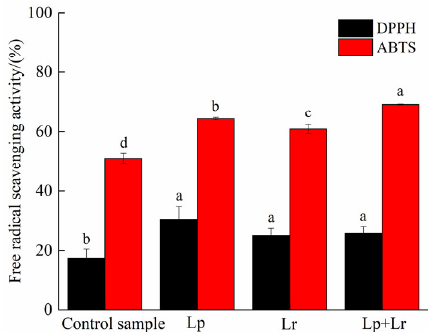
Figure 7. DPPH radical scavenging activity and ABTS radical scavenging activity of edible grass during fermentation. Different superscript letters in the columns indicate significant difference ( p < 0.05). Abbreviations: Lp, Lactobacillus plantarum ; Lr, Lactobacillus rhamnosus ; Lp+Lr, mixture of Lactobacillus plantarum and Lactobacillus rhamnosus .